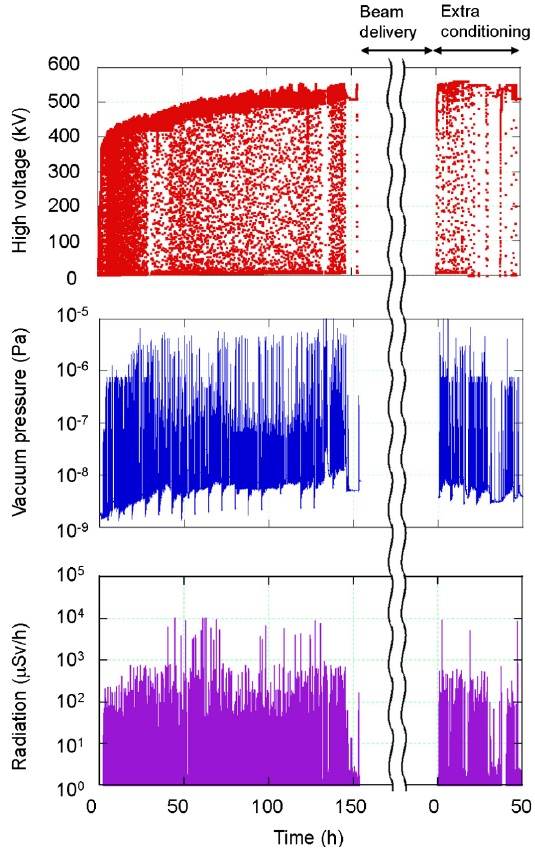
FIG. 11. Gun conditioning results as a function of integrated time for eight- plus two-segment insulator with cathode in place. The HV, the gun vacuum pressure, and the radiation are represented by red, blue, and purple curves, respectively. Approximately 200 h of beam delivery occurred at voltages 390 and 450 kV after 155 h of conditioning. Then extra gun conditioning was performed for 50